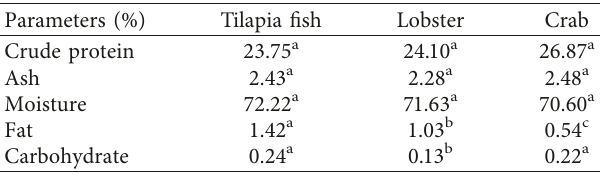
Table 2: The percentage mean proximate composition of the three seafoods.